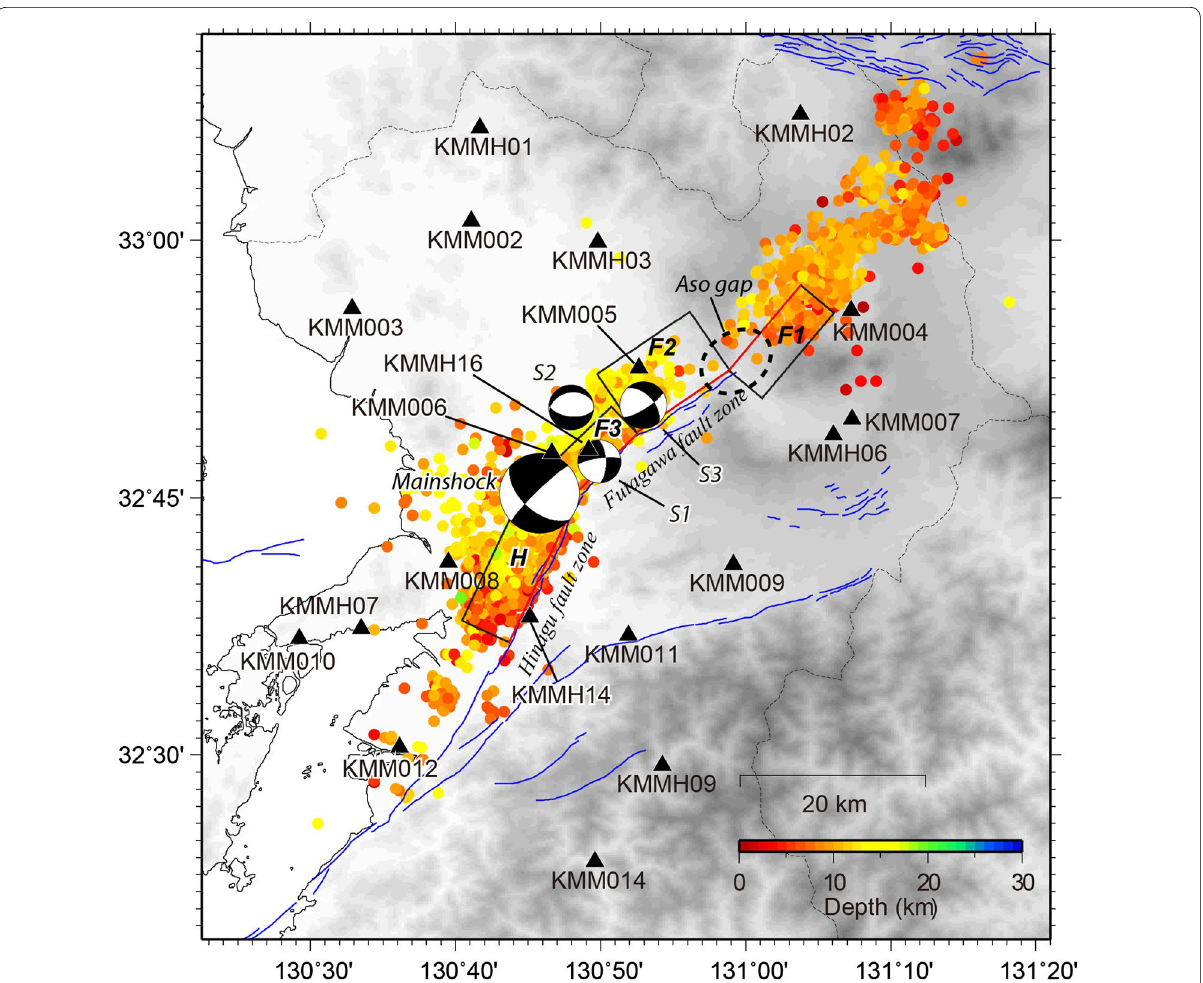
Fig. 1 Map showing aftershocks (after the JMA unified hypocenter catalogue) that occurred during the first 24 h after the mainshock, and the loca- tion of active faults ( blue line , National Institute of Advanced Industrial Science and Technology 2012). Triangles show the seismic stations used in this study. The moment tensor solutions of the mainshock and the moderate earthquakes ( S1 : 4/21 21:52 Mw3.9, S2 : 4/20 16:01 Mw4.0 and S3 : 4/15 15:27 Mw4.2) used in this study shown at the rupture starting point. The solutions are determined by NIED with F-net data. The surface projection of our four-segment initial fault model is shown by a rectangle . F1 , F2 , F3, and H indicate segment names. The top edge of the segment is indicated by the red